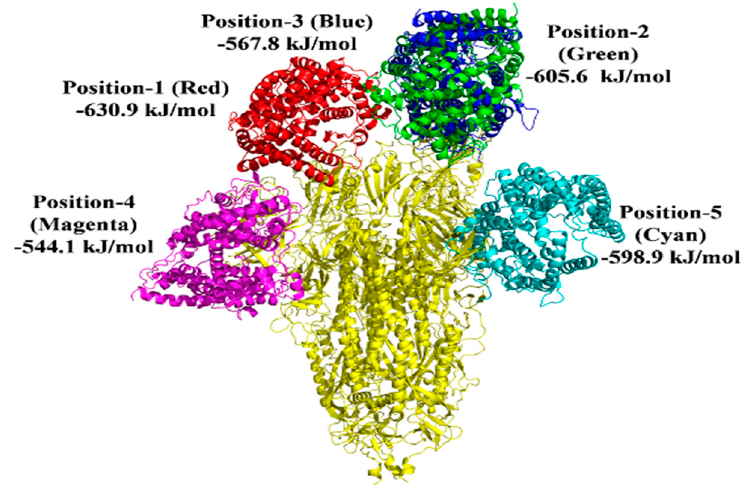
Figure 10. In the presence of imidazoquinolinone, the docked model depicts the S protein’s interaction with the ACE2 receptor. Table 2. Protein–protein interaction depicting five lowest binding energies for S protein-ACE2 complex in the presence or absence of Covaxin